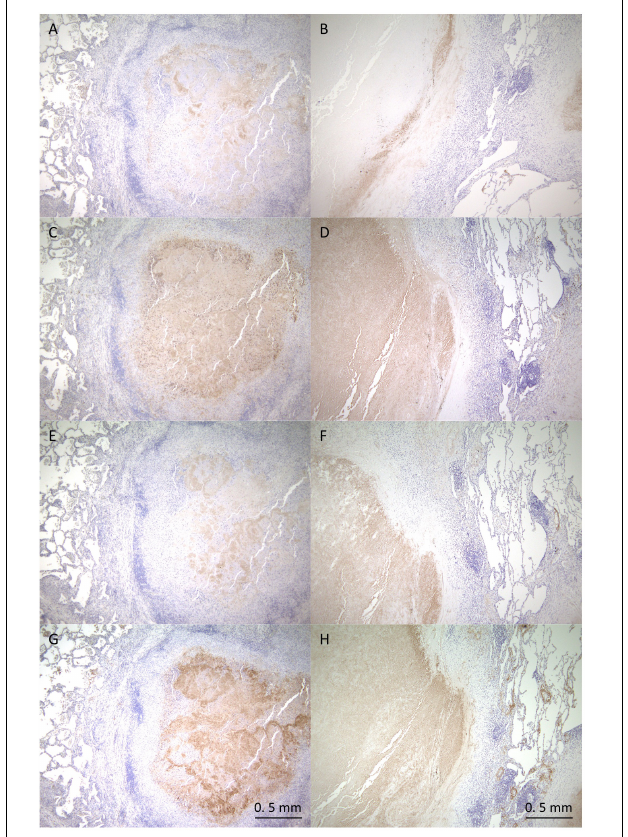
FIGURE 5 | Immunohistochemistry of proteins abundant in the caseous regions. FFPE are stained with anti-Fibrinogen gamma antibody (A,B) , anti-S100A9 antibody (C,D) , anti-ApoE antibody (E,F) or anti-Vitronectin antibody (G,H) . Images of granulomatous lesions from TB (A,C,E,G) or MAC-LD (B,D,F,H) are